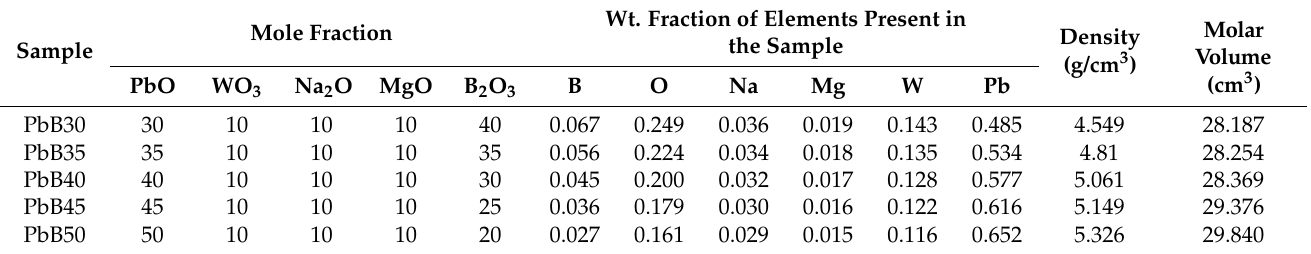
Table 1. Chemical composition of the selected